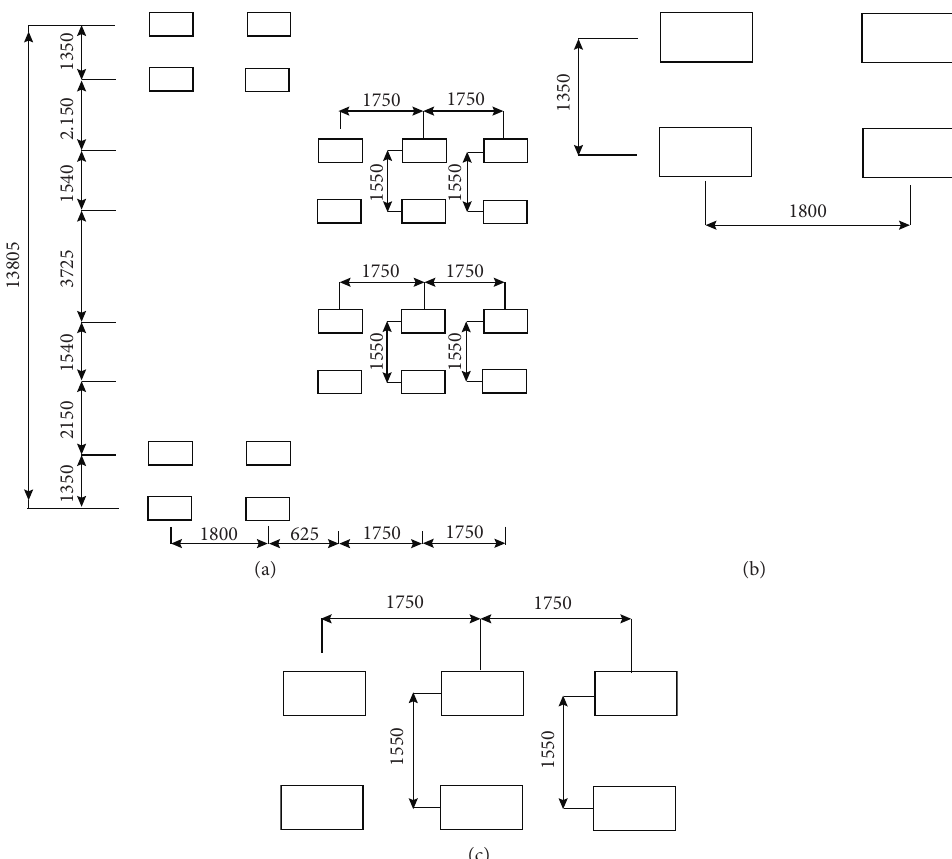
Figure 2: (a) Tire layout of the A380-800F model. (b) Biaxial and double-wheeled. (c) Triaxial and